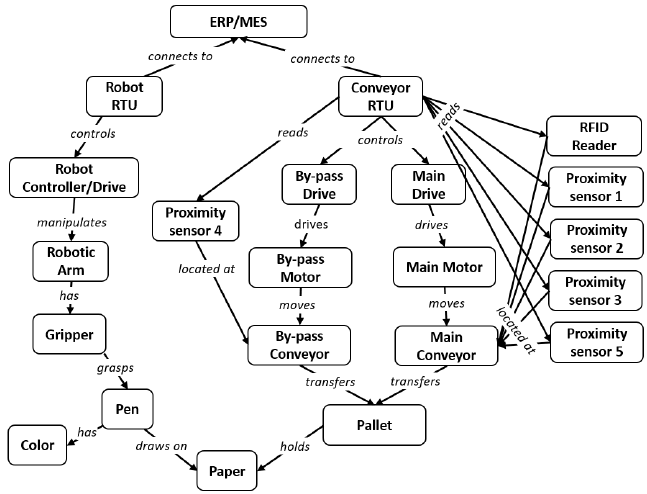
Figure 11. FASTory production resources description. [Source: Own